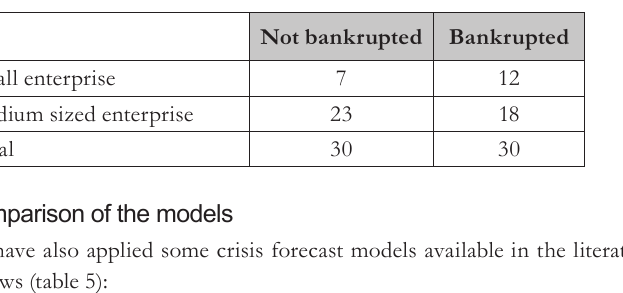
Tab. 4 – The validity sample’s values understood for company type and bankruptcy. Source: own